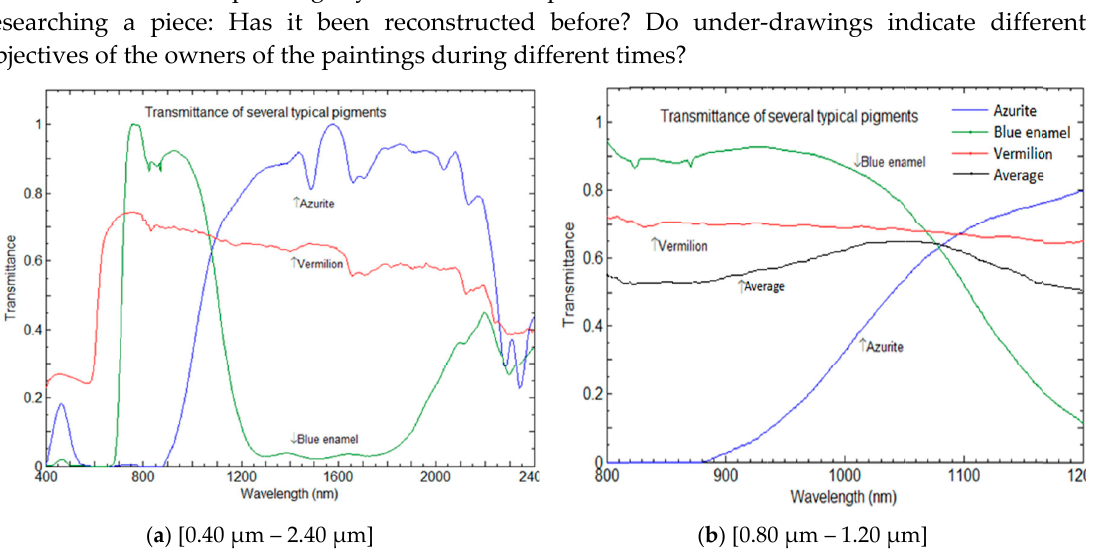
Figure 1. Transmittance of several typical paints, used historically in Italy in spectral region [0.80 μ m – 1.20 μ m], modified after [1], with permission. All three transmittance curves have about the same value of 0.65 at wavelength 1.080 μ m. The black transmittance curve [denoted average in part (b)] shows the average paint obtained by adding up all three contributions and dividing it by 3. It has a broad peak at about 1.050 μ